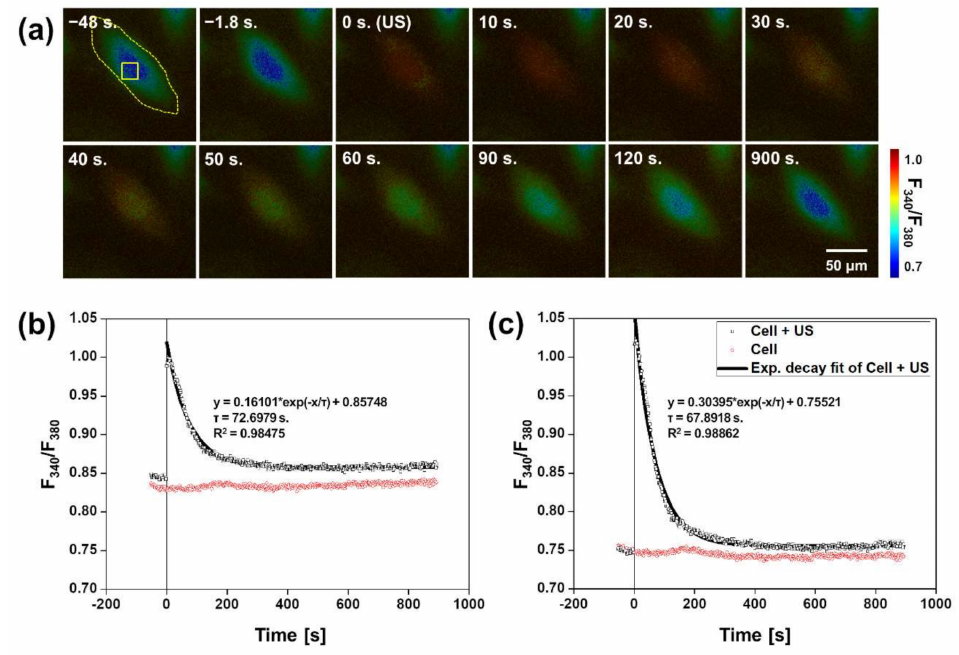
Figure 3. ( a ) Time-elapsed images of a ratio ( I λ = 340 nm /I λ = 380 nm ) between fluorescence images of Fura-2 AM excited at a wavelength of 340 and 380 nm. Background signals were corrected in each excitation wavelength. A criterion of 0.0 s is when ultrasound was irradiated. An inlet yellow box indicates a region of interest to determine quantitative ratios that mean calcium flux of the cervical cancer cell with the ultrasound-microbubble cavitation. ( b , c ) Plots of quantitative ratios between fluorescence of Fura-2 AM in the cervical cancer cell with the ultrasound-microbubble cavitation and the cell without the cavitation. Figure 3b means the ratio for the entire region of cells, and Figure 3c indicates the ratio for a region of interest, which is represented as a yellow box, of the neighboring region in contact with the